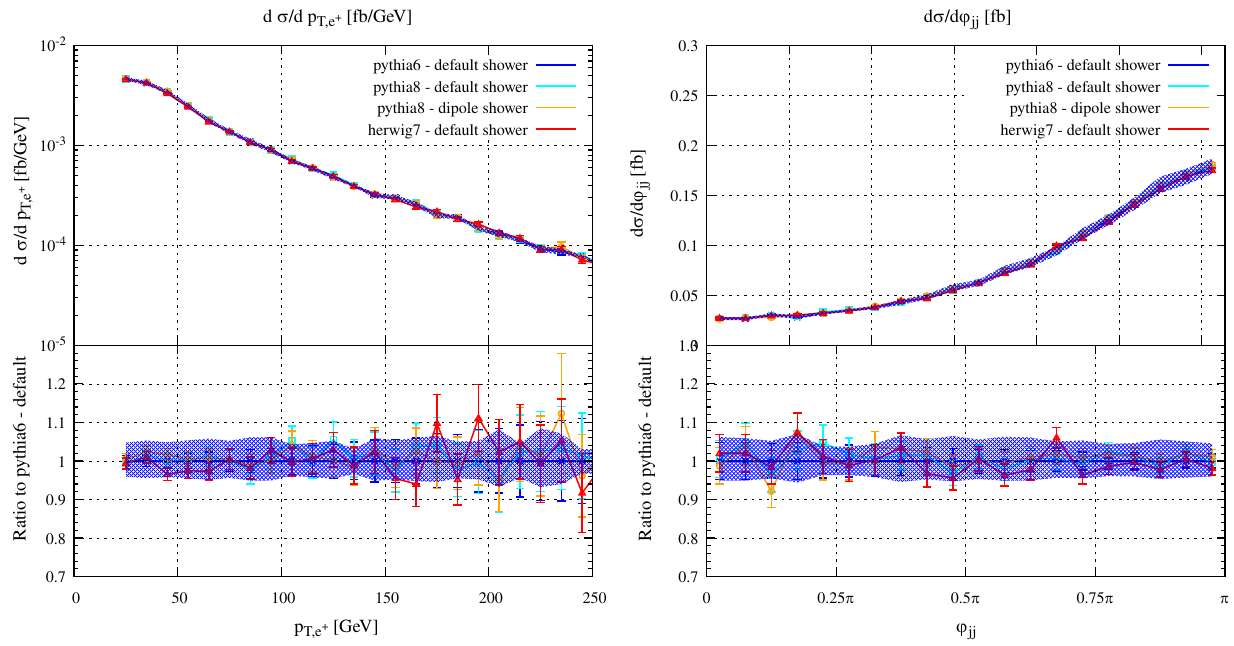
Fig. 2 Transverse-momentumdistributionofthehardestpositron(left) and azimuthal-angle separation of the two tagging jets (right) in the CMS-tight scenario. In the lower panels the ratio of the respective dis-